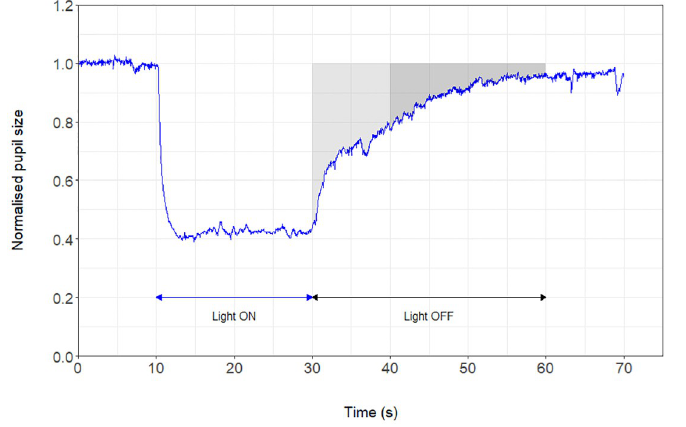
Fig 2. Flow diagram of enrolment in the study.